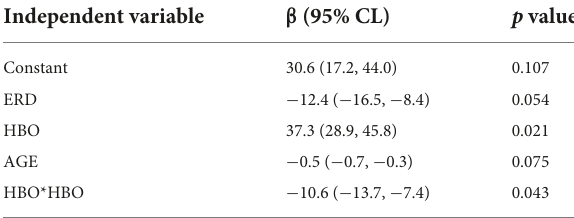
TABLE 2 Multiple linear regression